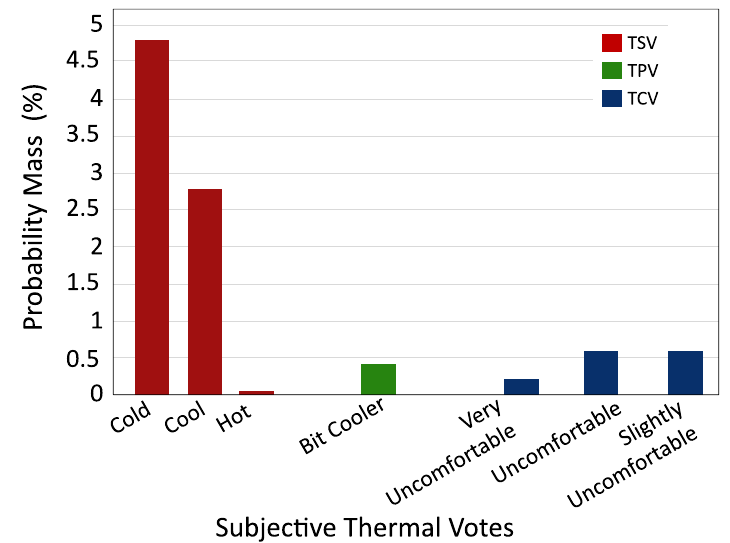
Figure 10. Class imbalance in primary student